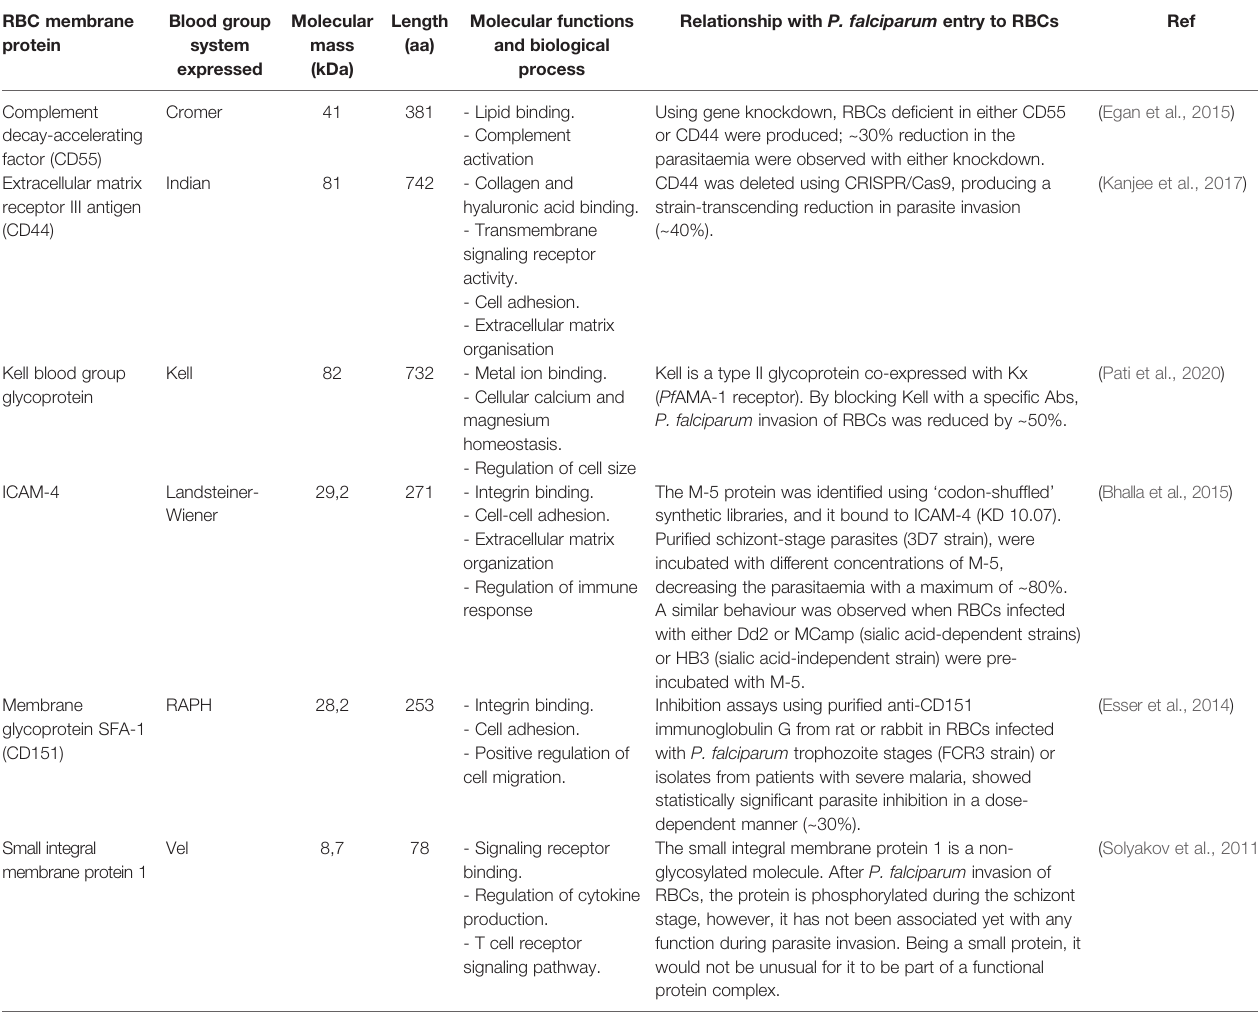
TABLE 2 | Potential Plasmodium falciparum RBC receptors. RBC membrane